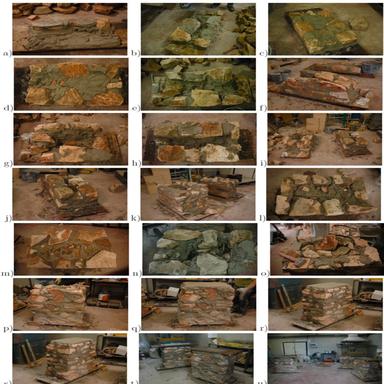
"Scaglia Rossa" limestone wall matrices construction steps with the application of the double leaves' technique of the four wall matrices.